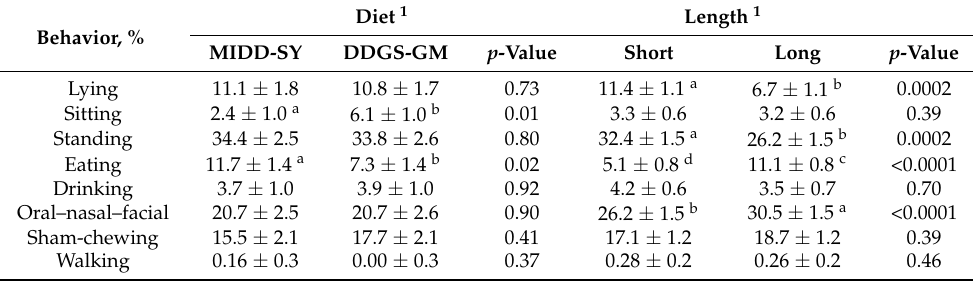
Table 3. Mean percentages of sow behavior registered between 06:00 h (30 min before feeding) and 09:00 h (2 h post-feeding) at 30-min intervals starting at 24 h post-mixing, and then at 3-week intervals until gestational